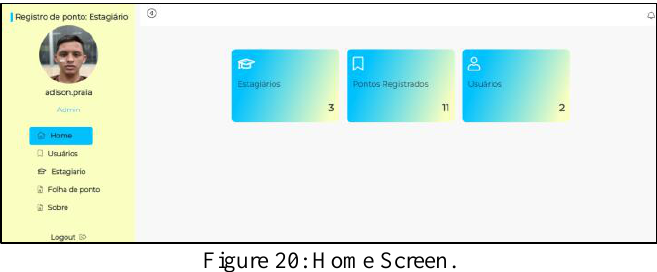
Figure 20: Home Screen.